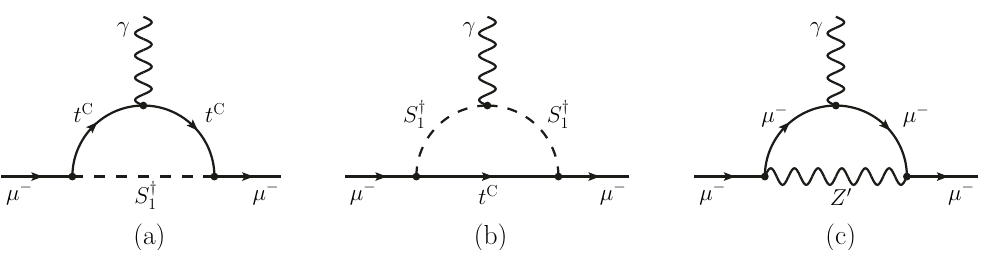
and Z 0 to the muon 1